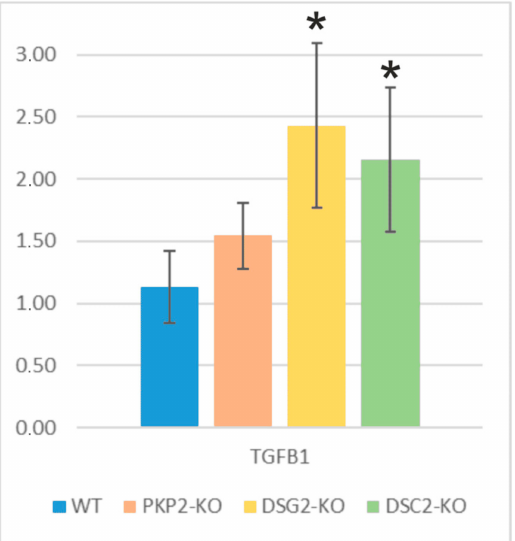
Figure 5. mRNA expression levels of several genes involved in ACM molecular pathways in the edited clones. * Indicates gene expression levels that were significantly different compared with WT clones; p -value < 0.05, see Table S8. Number of experiments: RT-PCR = 1.